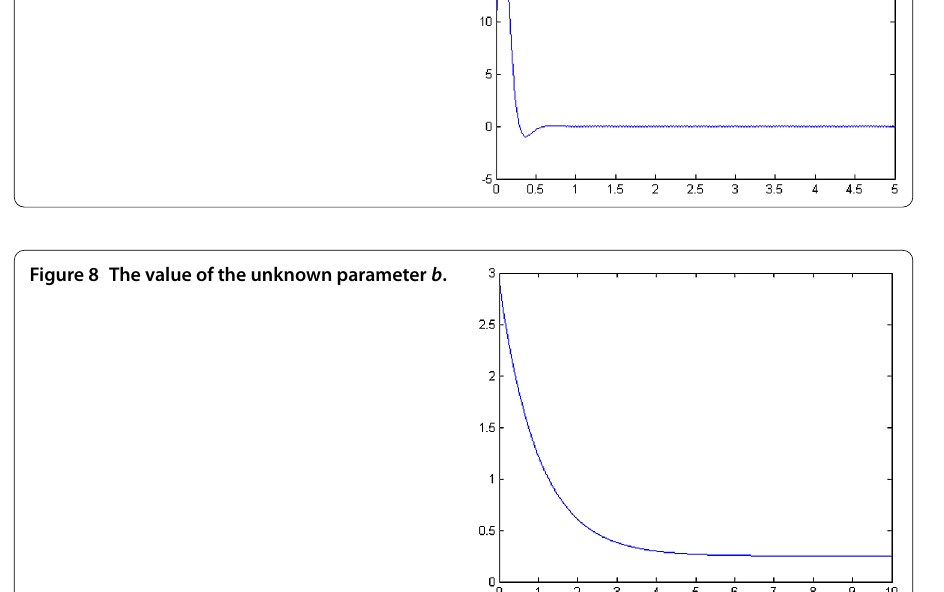
Figure 7 Error signal between the original and the recovered message.